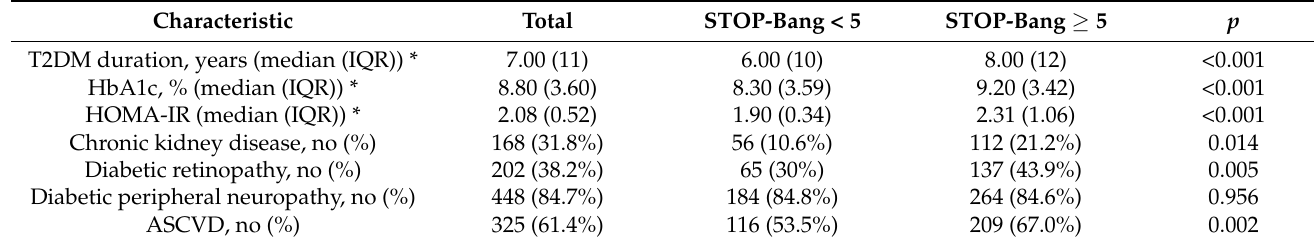
Table 3. Comparative analysis of the characteristics associated with T2DM.